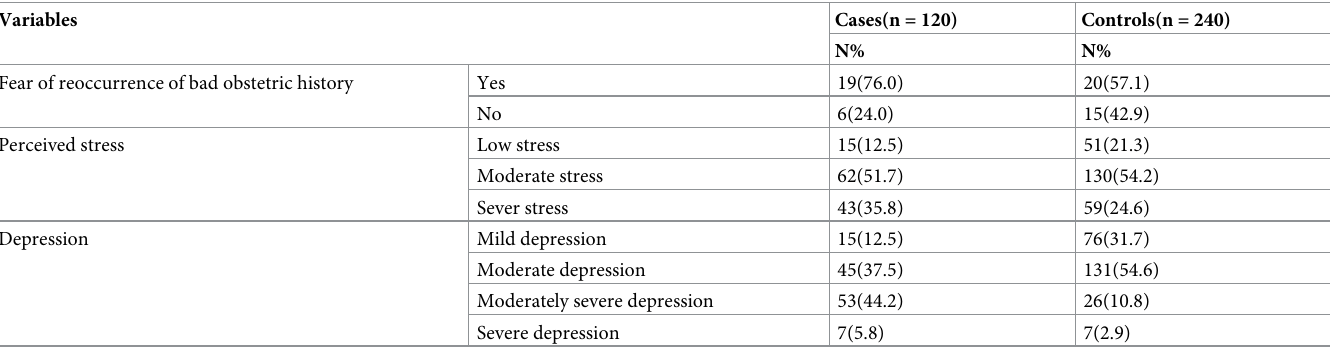
Table 3. Psychological characteristics of pregnant women attending health care service in public hospitals, southern Ethiopia,